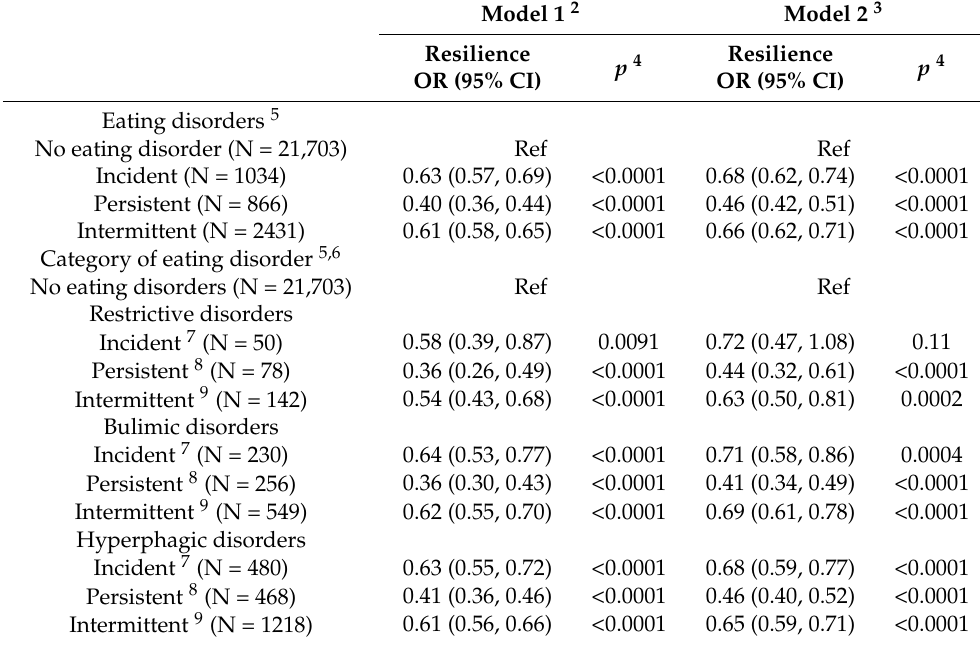
Table 3. Longitudinal associations between resilience (BRS) (independent variable) and eating disorders (EDs) (SCOFF questionnaire) (dependent variable) 1